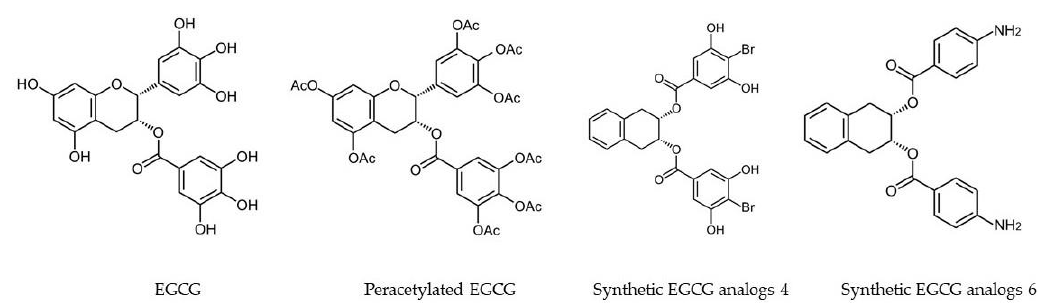
Figure 2. Molecular structures of ( − )-epigallocatechin-3-gallate (EGCG) and EGCG-based prodrugs and analogs.